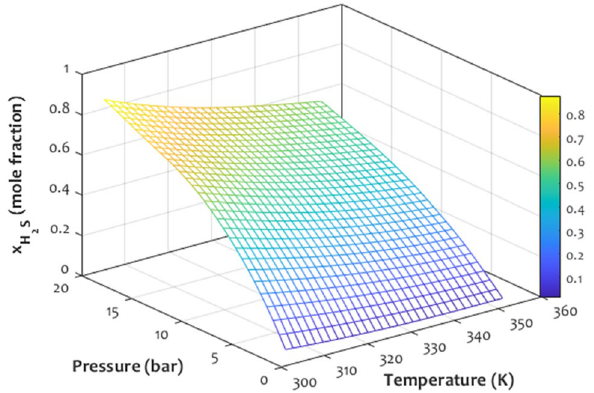
Figure 12. Three-dimensional illustration of temperature and pressure coupled effect on the H 2 S solubility in [OMIM][Tf 2